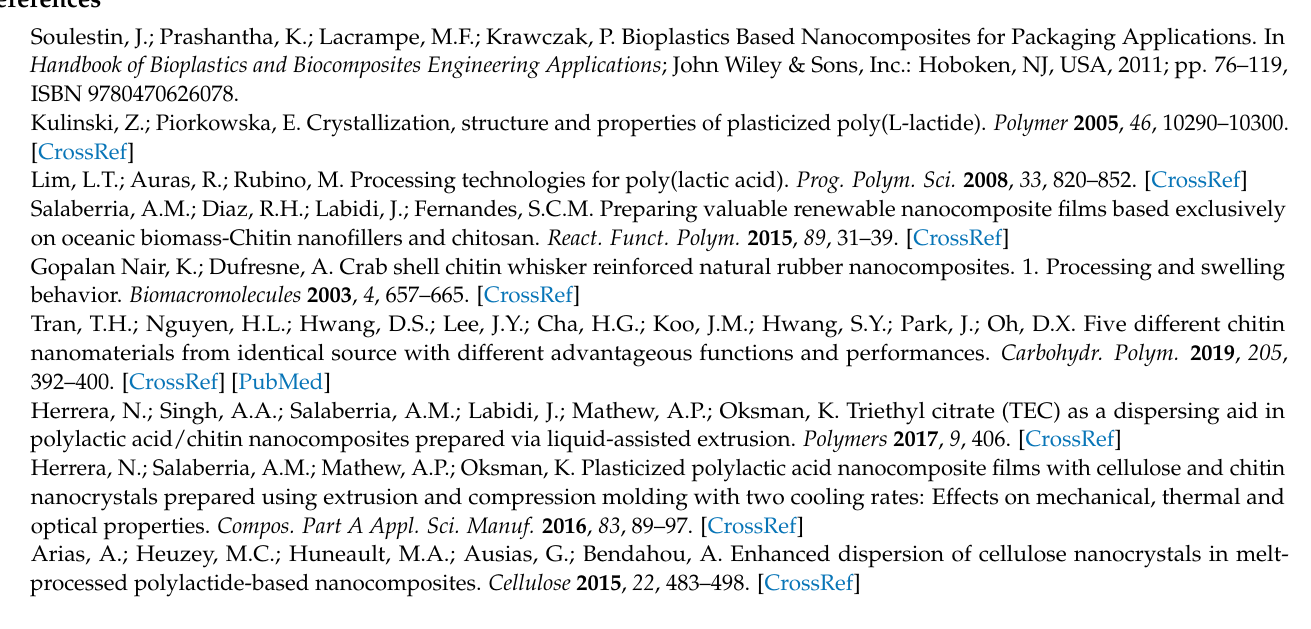
Figure S3. Image analysis of the CHNC dispersion in the nanocomposite films. Figure S4. Tensile properties of the plasticized materials and their respective counterpart nanocomposites. Table